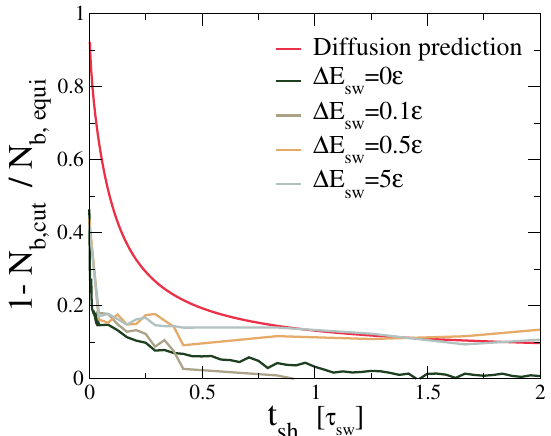
Figure 8. The asymptotic approach of the number of bonds in the region around the cut ( N b , cut ) to its bulk equilibrium value. N b , cut is the number of bonds in the region 40.5 σ ≤ z ≤ 43.5 σ . It is normalized by the average number of bonds at equilibrium. The same quantity is underestimated by the diffusion with the maximum D corresponding to ∆ E sw = 0. This causes discrepancies between the actual healing and the one predicted by a purely diffusive argument. Even when swaps are hindered by energy barriers, some bridges emerge quickly across the cut, initiating a slower healing